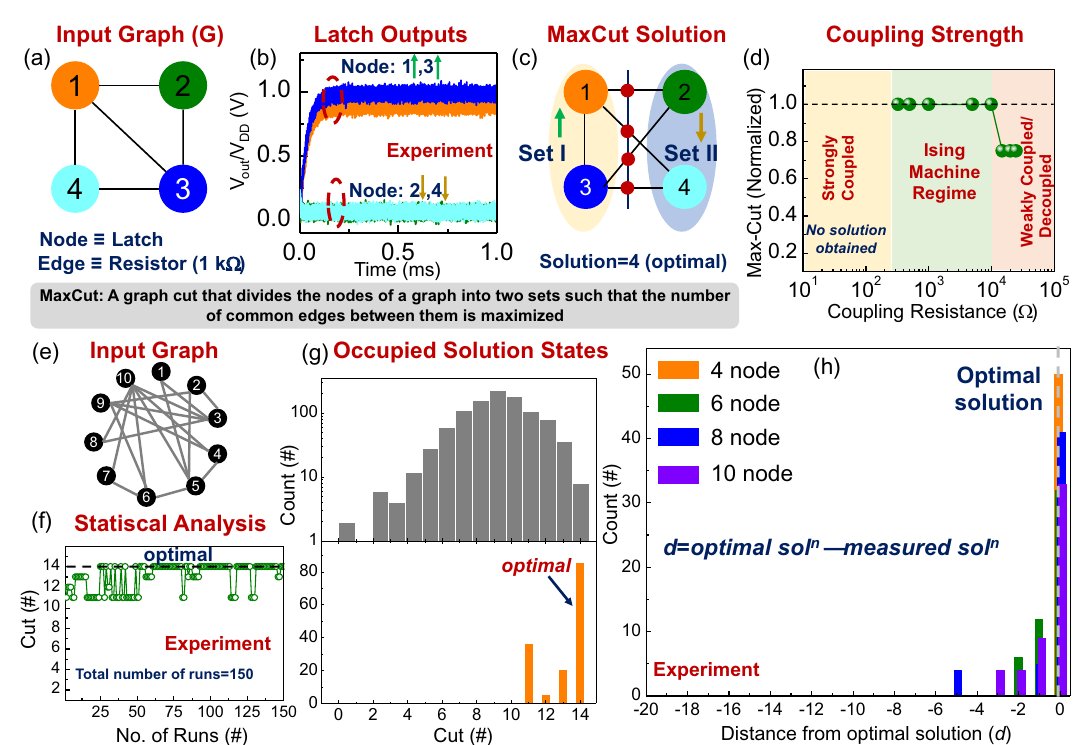
Figure 3. Solving MaxCut using latch based ising machine. ( a ) A representative 4 node graph problem. ( b ) Time domain outputs of the negative coupled (J ij = − 1) CMOS latches for the input graph. ( c ) MaxCut solution measured using the latch outputs in ( b ). ( d ) Effect of coupling resistance on the solution quality. ( e ) A representative network of 10 spins with randomly generated interactions (represented by edges). ( f ) Experimentally observed MaxCut solution over 150 trials, illustrating the statistical behavior of the Ising machine. ( g ) Distribution showing occupied solution states (represented by cut values) and their frequency (orange) compared to the complete solution space (grey) for the problem. ( h ) Experimentally measured MaxCut solutions measured for multiple graphs of various size from 4 to 10 nodes. Each graph is measured 10 times, and the measured solution is represented by its distance d from the optimal